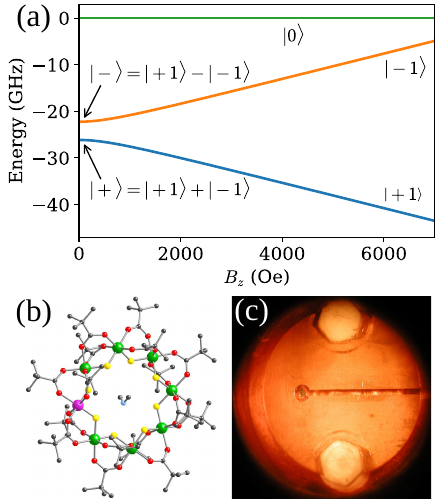
Figure 1. ( a ) energy-level diagram for a Cr 7 Mn molecule, showing the zero-field avoided crossing between | m = ± 1 (cid:105) states, creating the |±(cid:105) clock states; ( b ) molecular structure of Cr resonator with a Cr 7 Mn sample in the